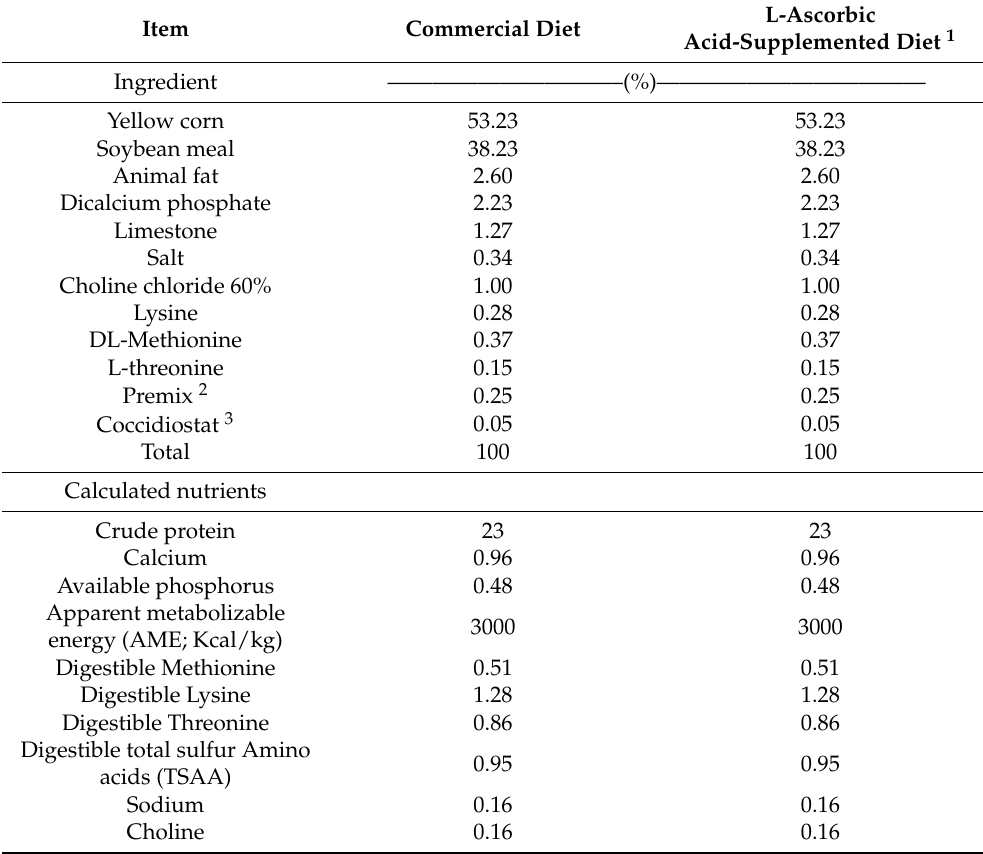
L-Ascorbic Acid-Supplemented Diet 1